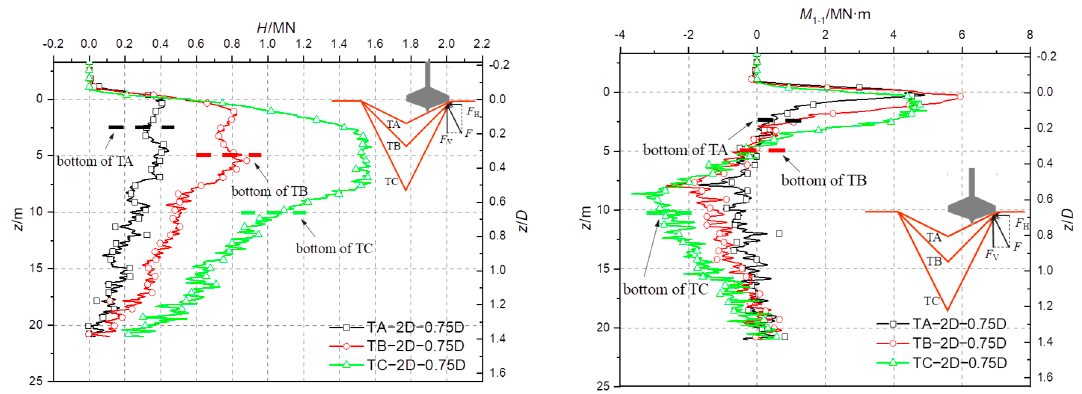
( b ) Effect of footprint geometry on fusiform spudcan footing ( β = 0.75 D )